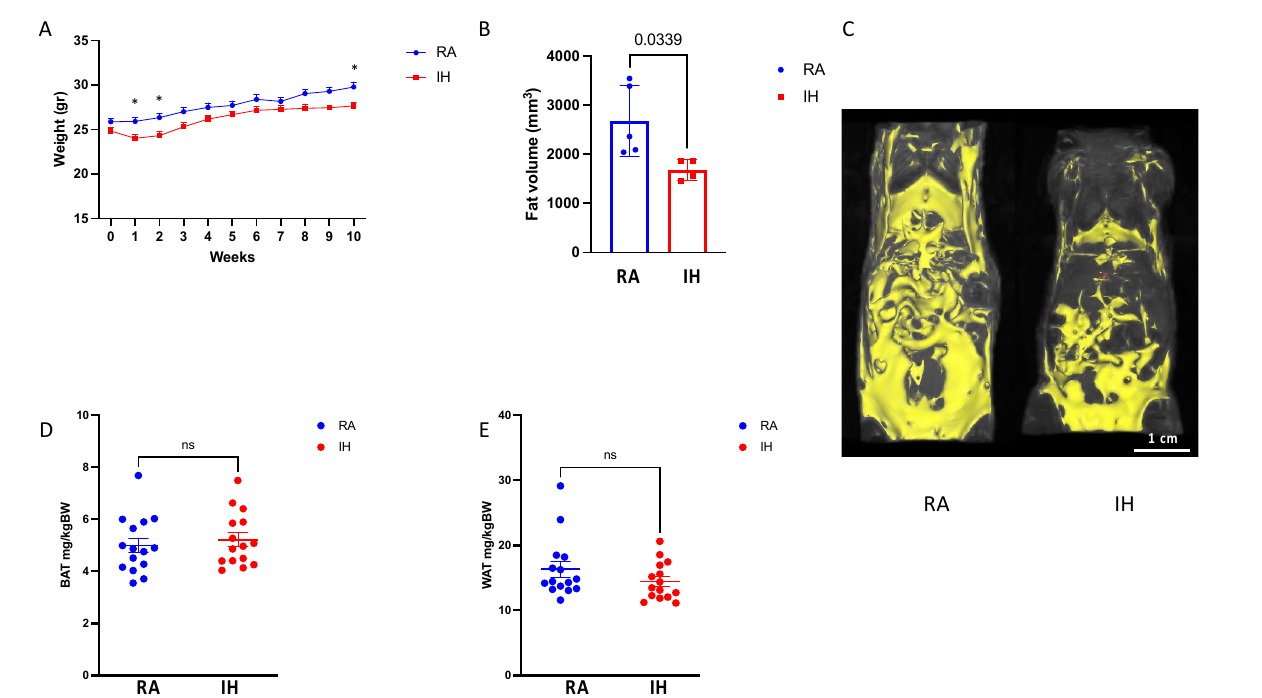
Figure 1. Chronic intermittent hypoxia exposure results in lower body weight and adiposity. Body composition comparison of mice exposed to chronic intermittent hypoxia or room air conditions ( n = 14–15). ( A ) Weight gain trajectory throughout the exposure. ( B ) Whole body fat volume derived from the MRI scans ( n = 4–5). ( C ) Representative MRI images from each of the experimental groups demonstrating reduced adiposity in IH with preservation of visceral fat (right panel). ( D ) Brown adipose tissue (BAT) weights normalized to body weight. ( E ) Visceral fat (WAT) weight at the end of exposure normalized to body weight. Data are presented as means ± SEM. Pairwise comparisons were performed using Student’s t -test. * p -value below 0.05. Weight statistics ( A ) were compared with two-way ANOVA using repeated measures and correction for multiple comparisons. ns–non-significant.